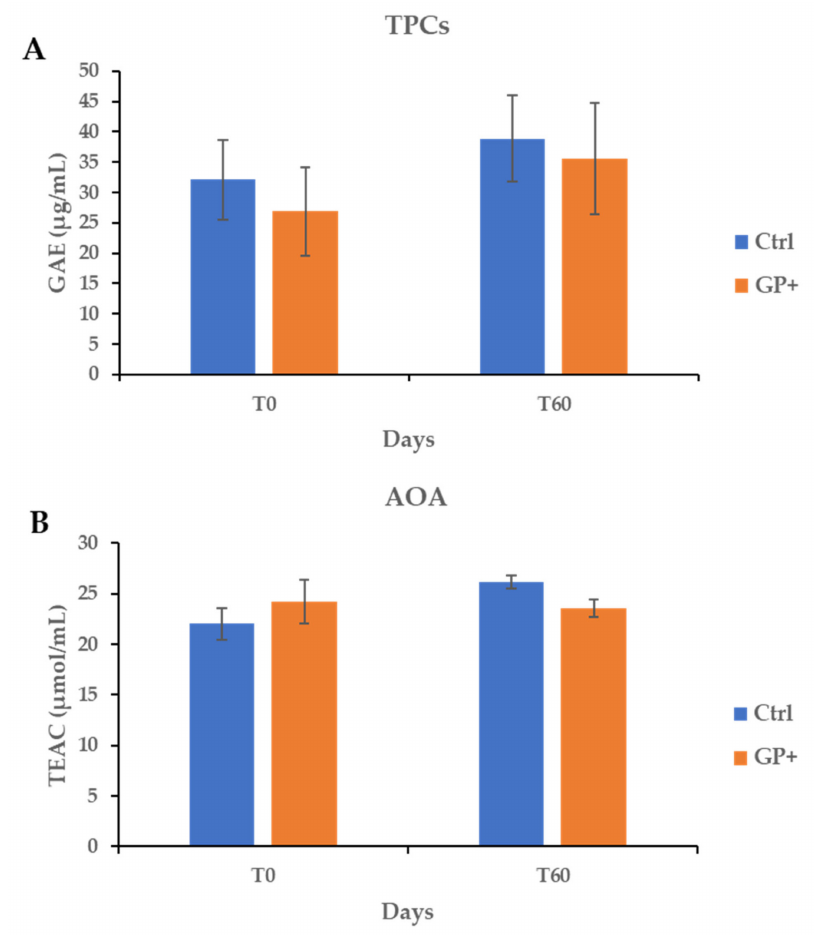
Figure 1. Total Phenolic Compounds (TPCs) ( A ) and Antioxidant Activity (AOA) ( B ) at the beginning (T0) and after 60 (T60) days of trial in raw milk samples obtained from ewes fed a standard diet (Ctrl) and grape pomace diet (GP+). GAE = gallic acid equivalent; TEAC = trolox equivalent antioxidant capacity. Data are reported as mean ± SE for n = 23. Differences between Ctrl and GP+ were not significant ( p >